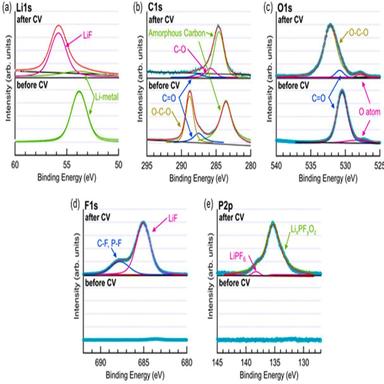
Typical XPS narrow spectra of (a) Li1s, (b) C1s, (c) O1s, (d) F1s and (e) P2p with peak fittings for Li-C nanocomposite films before and after CV measurement.